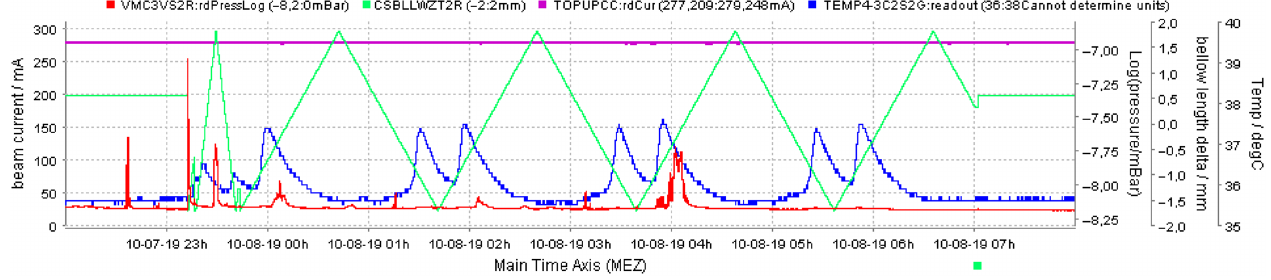
FIG. 11. CSB1 pressure gauge (red) and temperature (blue, °C) readout during cyclic length variation (green). A clearly length- correlated temperature signal is observed during the entire experiment, while the pattern of the pressure reaction disappeared after a strong peak at the beginning of the third long cycle, indicating a conditioning